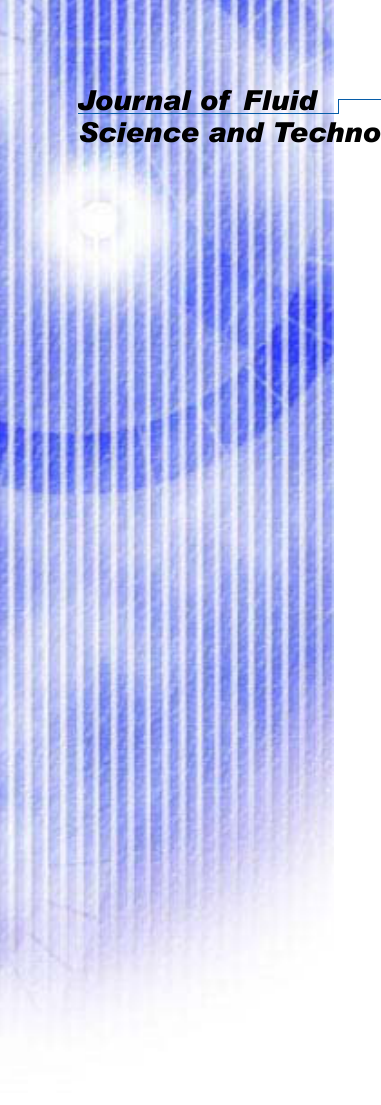
Paired electrodes for void fraction